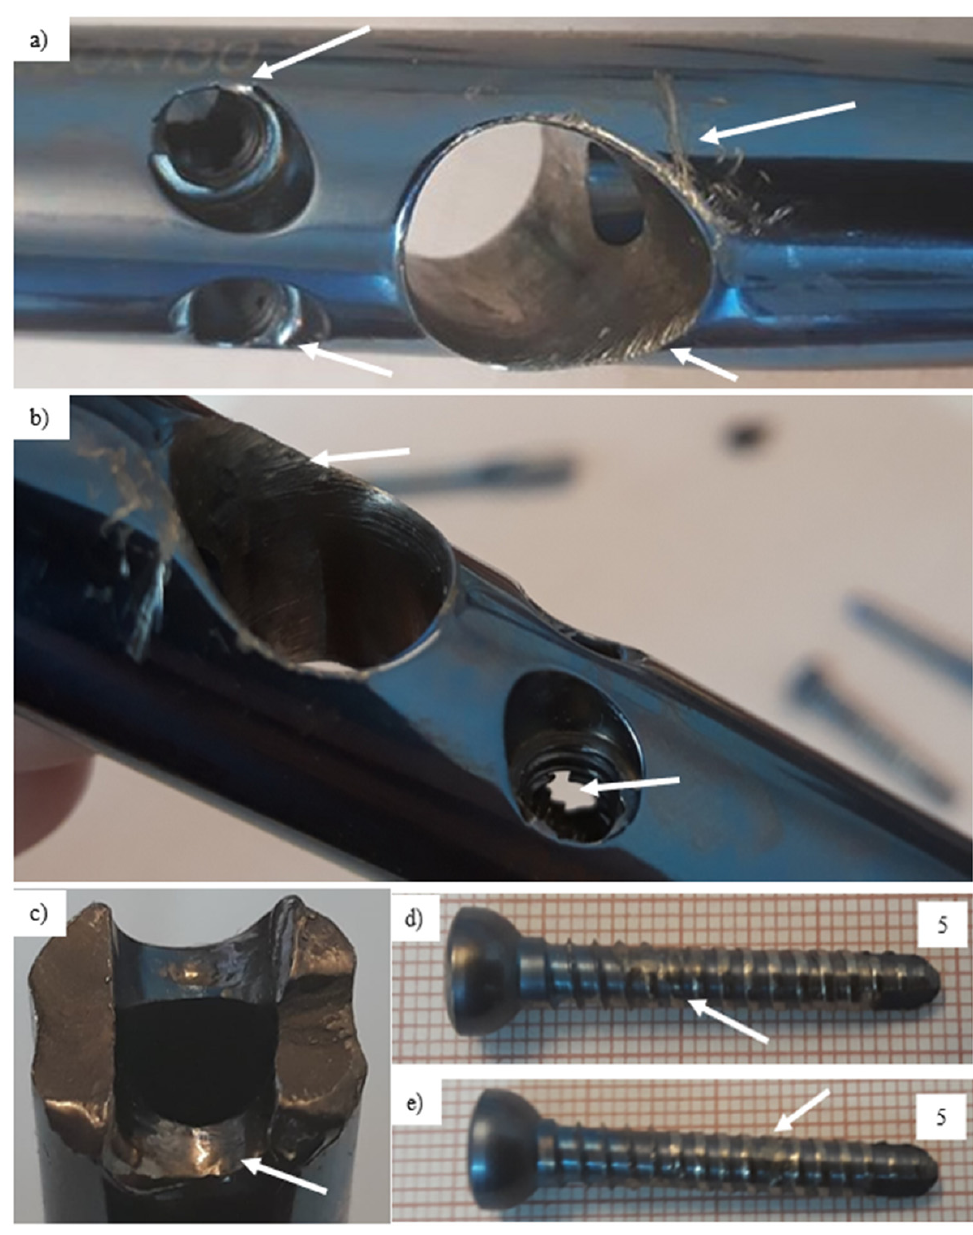
Figure 11. Visual inspection of the exploited part (number 1 in Figure 9a) of the titanium implant: worn marks ( a ); broken hole thread ( b ); fracture surface with area of wear ( c ); broken threads of screws ( d , e ) (number 5 in Figure 9b).